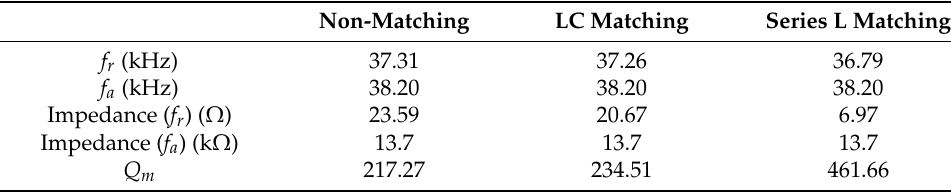
Table 1. Summary of MATLAB simulation results.